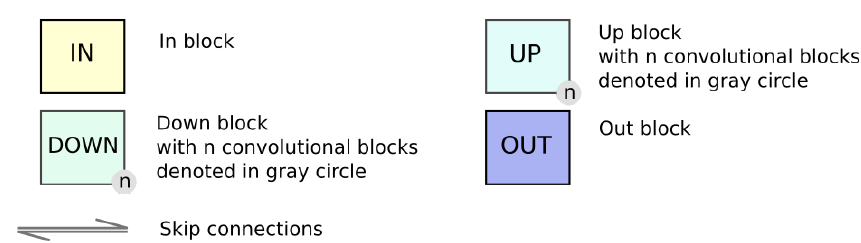
Figure A1. Block diagram of the 3D base configuration architecture. It comprises input blocks, output blocks, up blocks, and down blocks along with skip connections as described in Section 3.3. The input to the network is a patch of size 320 × 320 × 16 and the output is of the same dimension. The legend to the bottom of the dotted line indicates information about individual model